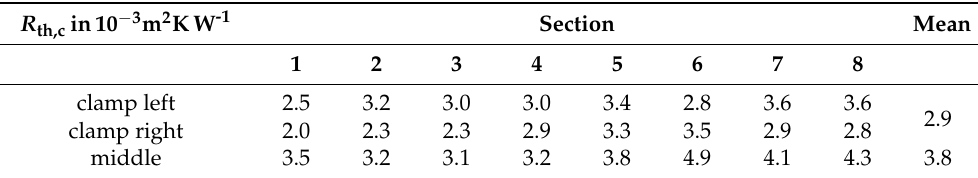
Table 4. Determined specific thermal contact resistances by experimental temperature measurement at the heating rod and rail surface and according to FEM